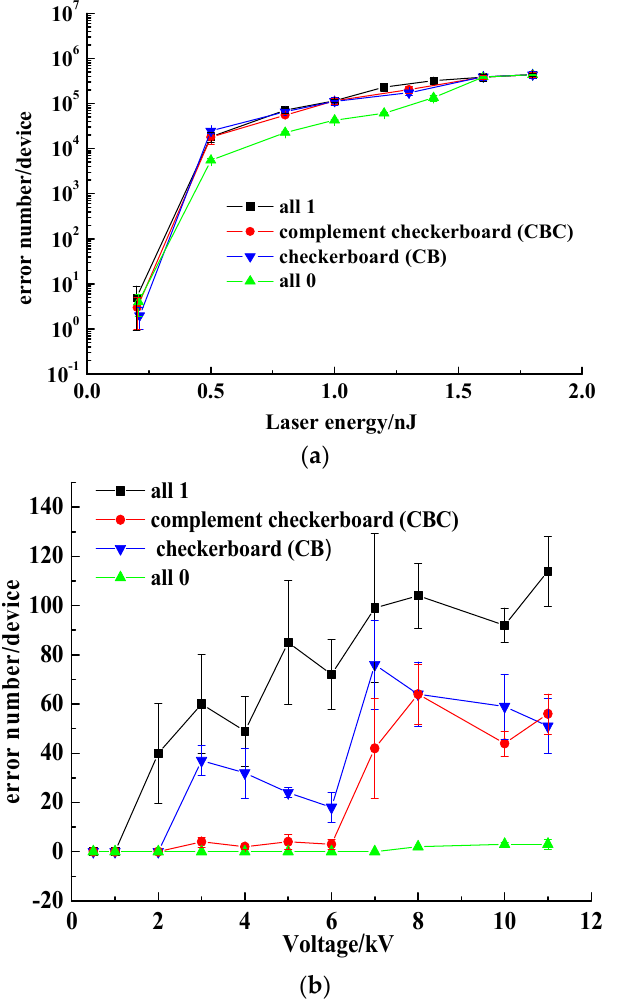
Figure 9. The characteristics of bit-errors for the SRAM as a function of ( a ) pulsed laser energy; and ( b ) SESD voltage.